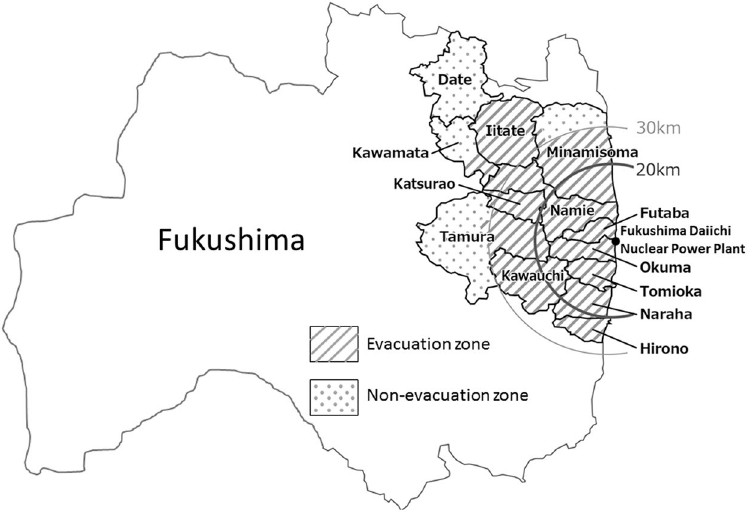
Figure 4. Map showing the location of the Fukushima Daiichi Nuclear Power Plant, the evacuation zone, and the non-evacuation zone. The map was created by authors using Adobe Illustrator CS6 and Microsoft Power point 2010 software based on the map of Assistance of Residents Affected by the Nuclear Incidents (Ministry of Economy, Trade and Industry of Japan) (http://www.meti.go.jp/english/earthquake/nuclear/roadmap/